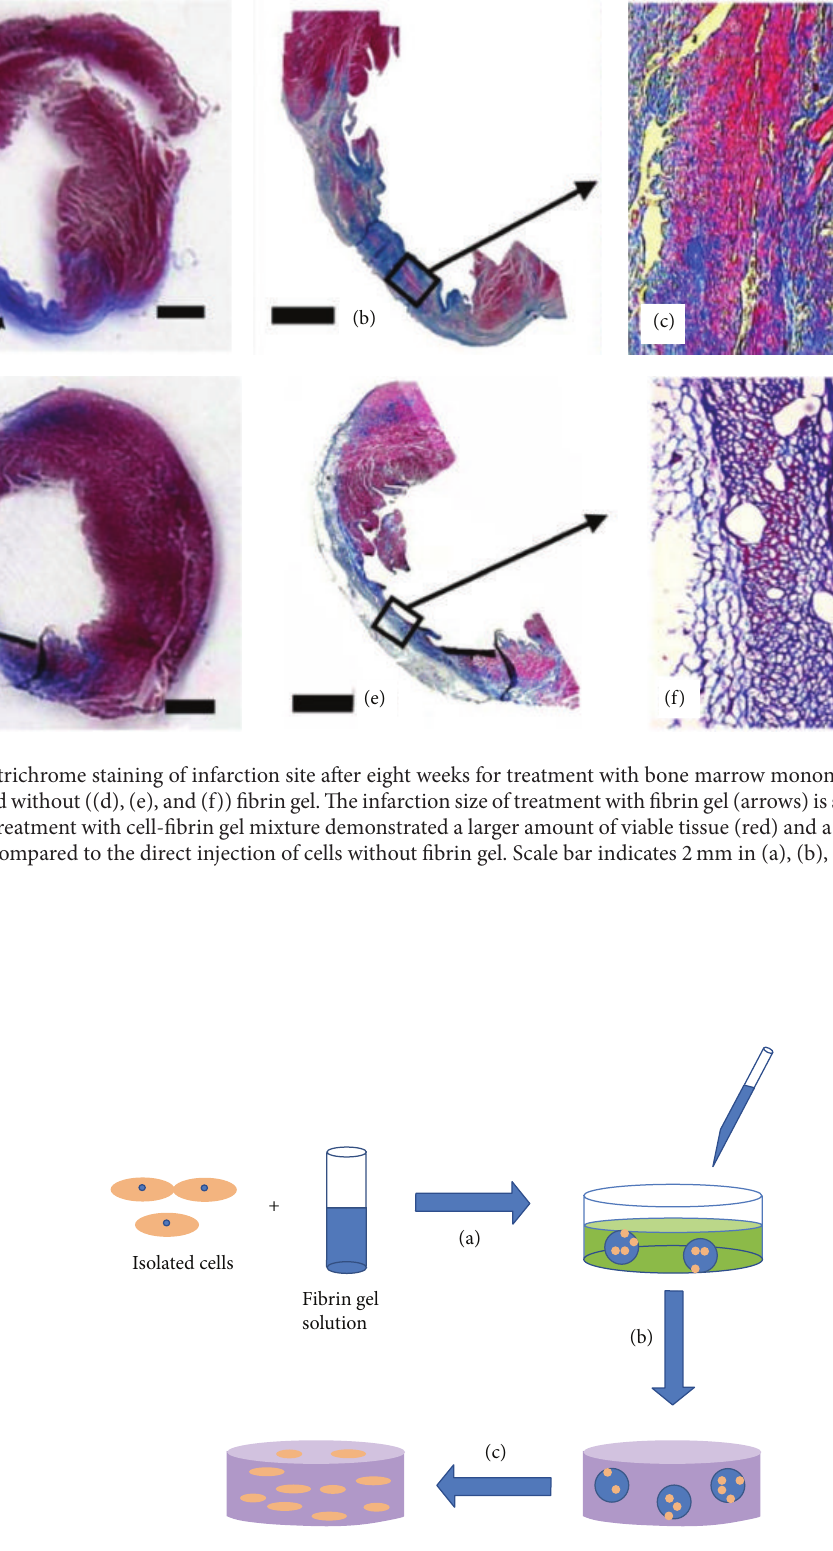
Figure 6: Isolated cells are suspended in fibrin gel solution. The cell suspension is added into cross-linking agent solution dropwise to form microbeads (a). The microbeads are mixed into injectable scaffold solution and injected into a mold (b). The microbeads degrade gradually and leave micropores in the three-dimensional scaffold for the migration and proliferation of released cells